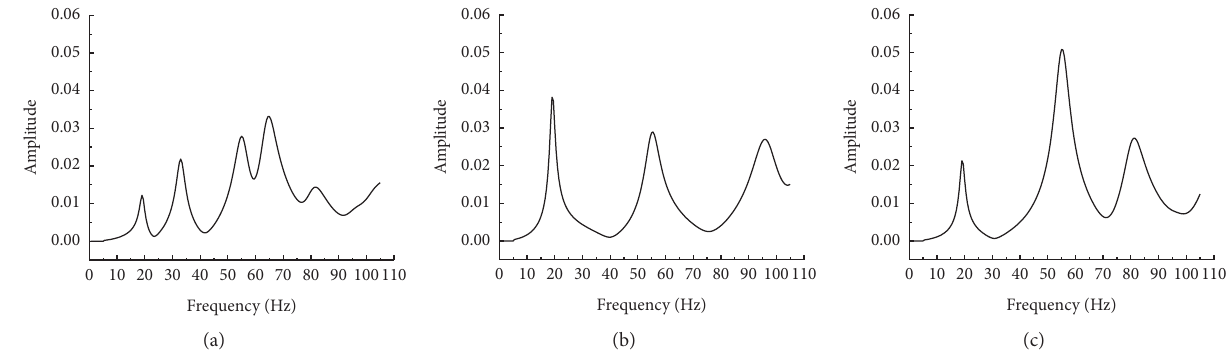
Figure 3: DA at various locations: (a) location A; (b) location B; (c) location